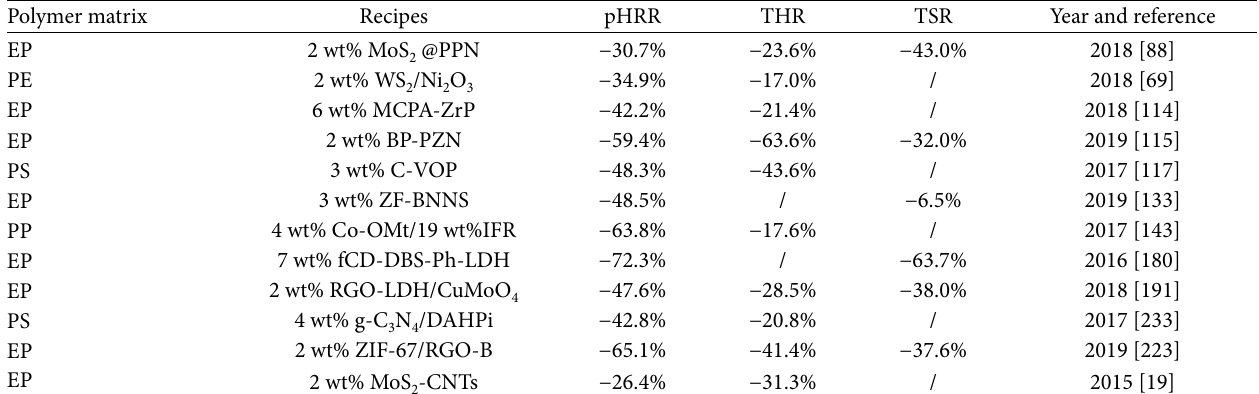
Table 2: Burning parameters of two-dimensional nanomaterials/polymer composites. Polymer